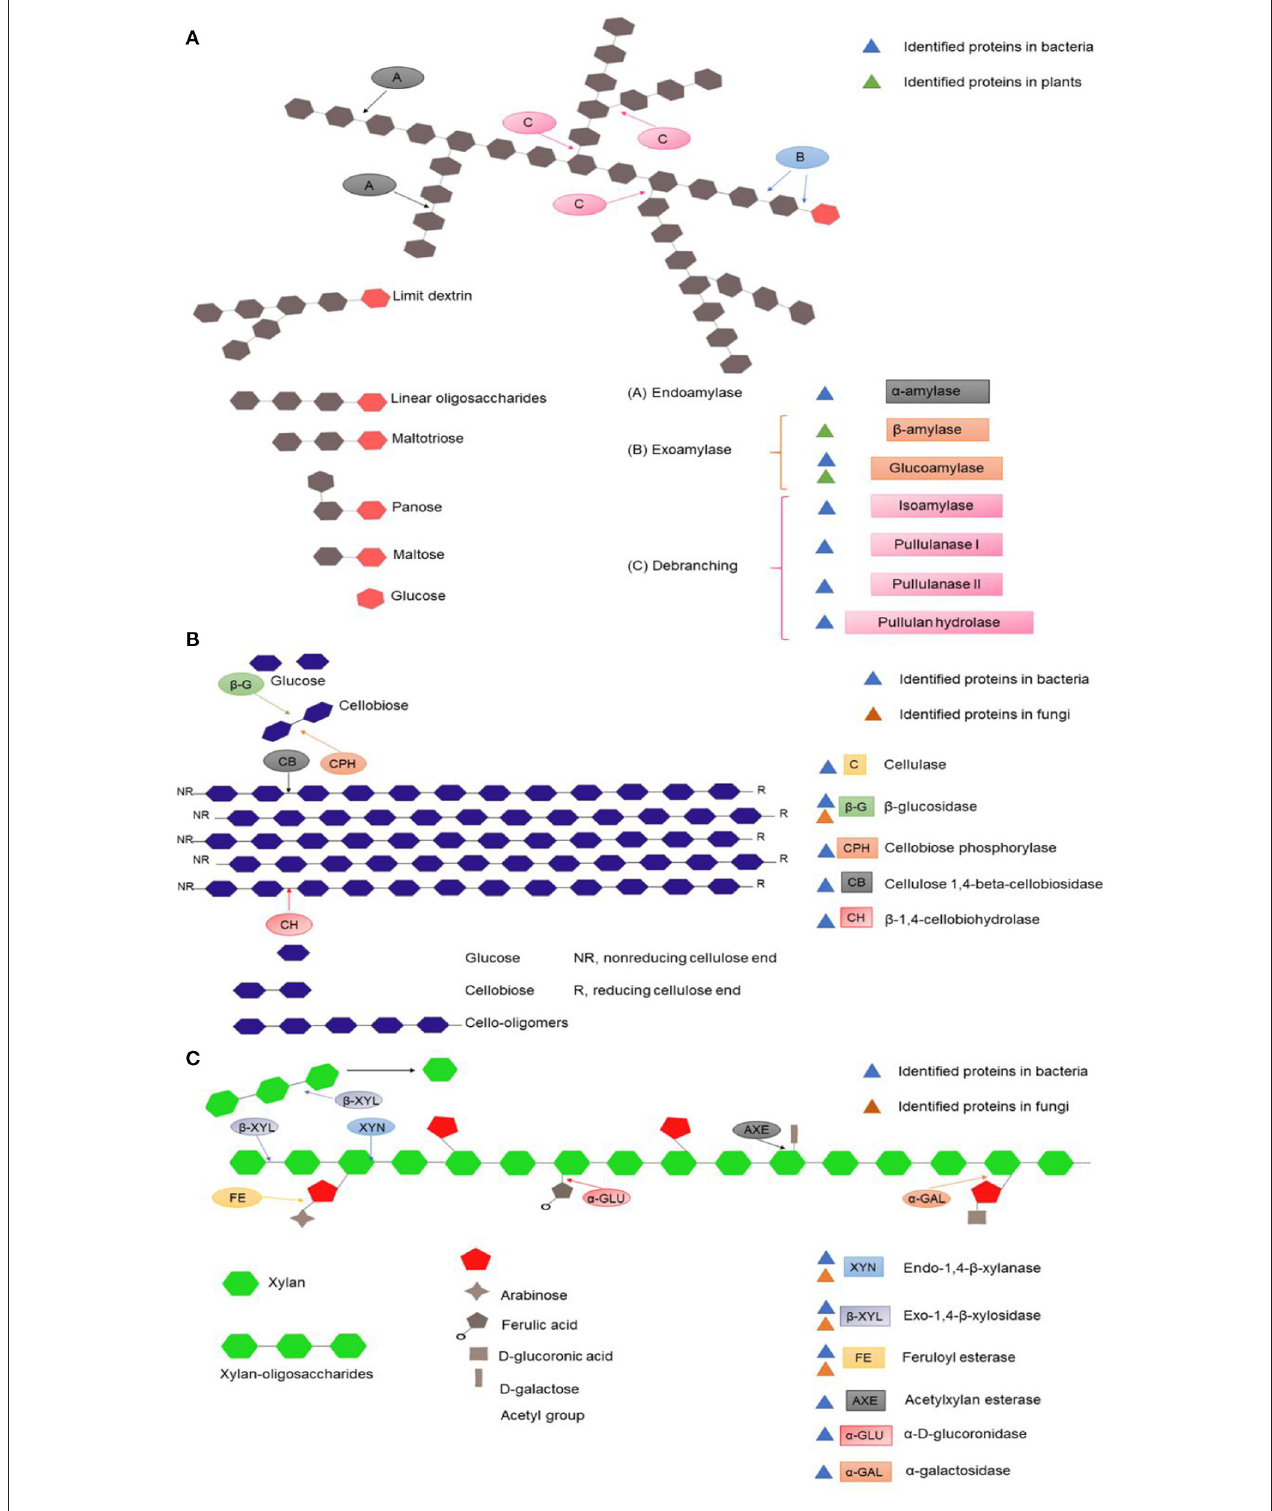
FIGURE 7 | Schematic representation of the different polysaccharides presents in maize dough and the enzymes implicated in their degradation. (A) Identified proteins for starch hydrolysis; (B) Identified proteins for cellulose hydrolysis; (C) Identified proteins for arabinoxylan.